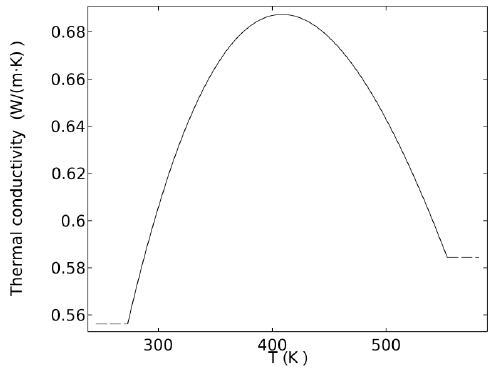
Figure 5. The thermal conductivity of the water changes with temperature.